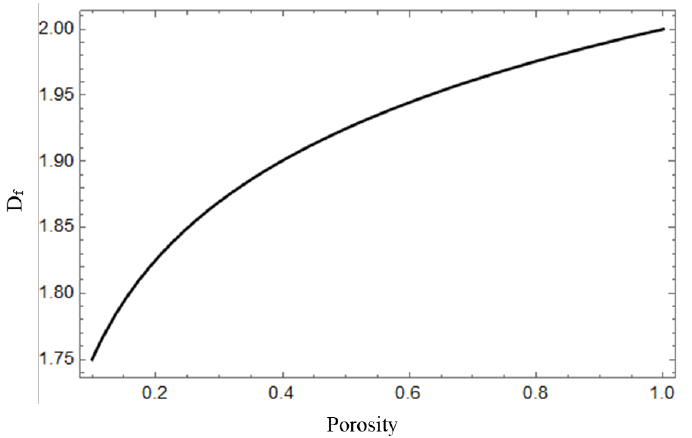
Figure 9. Effect of porosity on area fractal dimension. When the maximum pore diameter of the porous materials is 1000 µ m and the mini- mum pore diameter is 0.001 µ m, the area fractal dimension varies with the pore diameter distribution as shown in Figure 10, indicating that the area fractal dimension increases with the decrease in Φ min / Φ max . The pore structure of porous materials is more complicated when the pore size distribution is larger, and the area fractal dimension characterizes the spatial irregularity of the pore distribution of porous materials. Therefore, the area fractal dimension increases with the increase in the pore diameter distribution. On the other hand, the area fractal dimension under the condition of constant minimum pore diameter and variable maximum pore diameter is larger than the constant maximum pore diameter constant and variable minimum pore diameter condition, which might be attributed to the average diameter being smaller in the constant minimum pore diameter condition. In other words, for the same porosity, smaller pore diameter gives larger area fractal dimension.